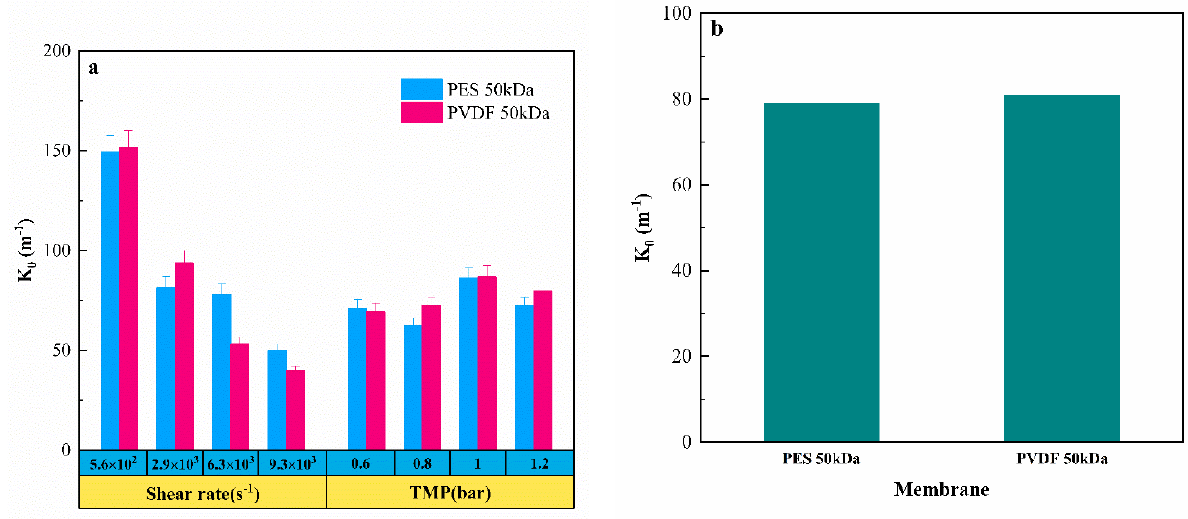
Figure 8. ( a ) Exponential fouling coefficient ( K 0 ) of two membranes in different operating conditions; ( b ) the K 0 mean values of the two membranes under different operating conditions.